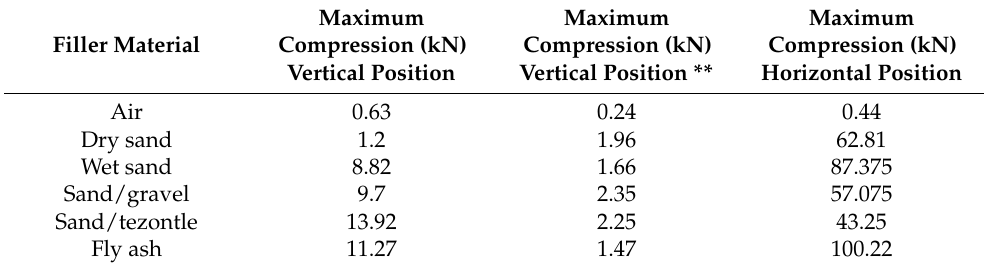
Table 1. Maximum load of a PET bottle under compression in both the vertical and horizontal positions